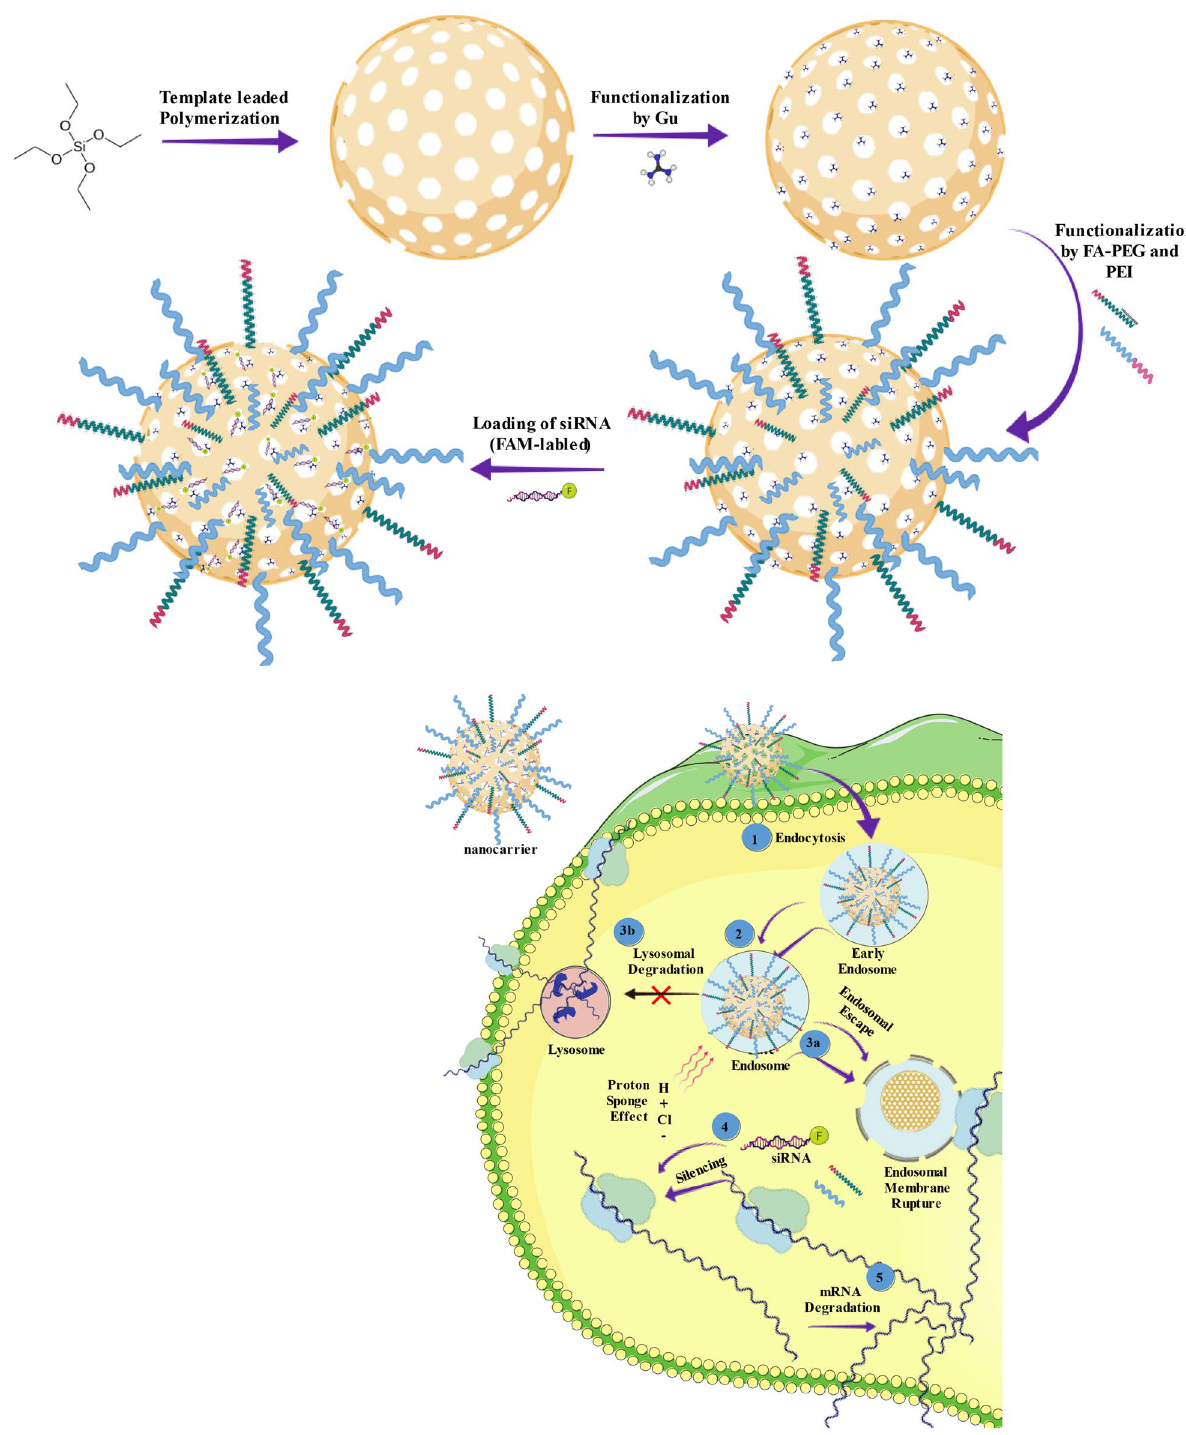
Figure 1. Schematic outline of the steps of modification of KIT-6 by GuIL, PEG, PEI 1and internalization of siRNA/Nanocarrier. 1. Nanocarrier enters the cell through endocytosis + /receptor-mediated endocytosis. 2. Formation of early endosome. 3a. Endosomal escape (proton sponge theory). 3b. Integration with lysosomes. 4. Incorporation of siRNA into RISC. 5. Target mRNA (EGFR1) induce cleavages and